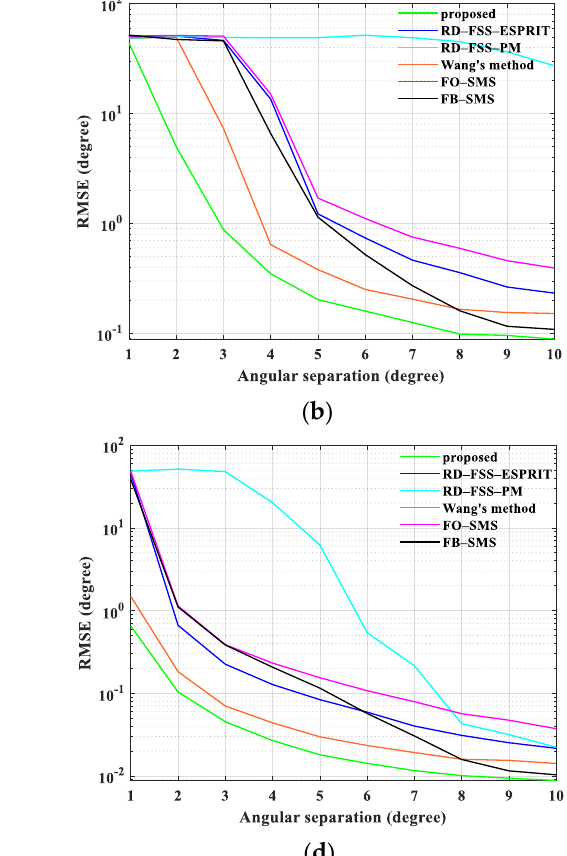
at θ k = 10 ◦ ,10 ◦ + ∆ , SNR = 0 dB; ( b ) Scenario 2: θ k = 60 ◦ ,60 ◦ + ∆ , SNR = 0 dB; ( c ) Scenario